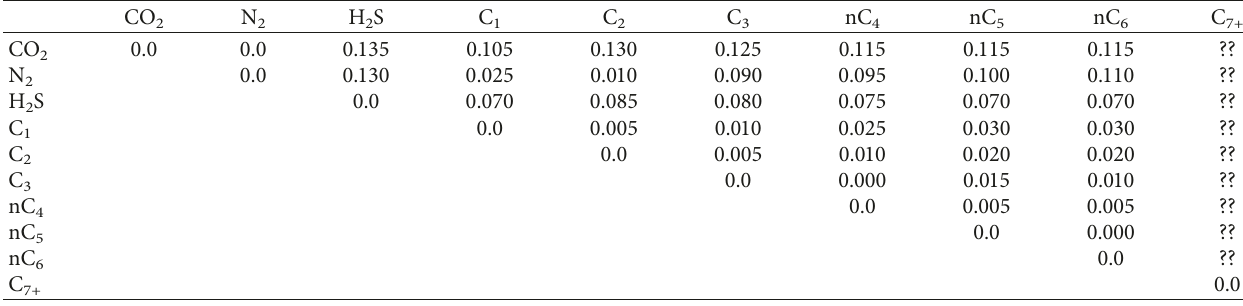
k � k ij . Here, ij ji